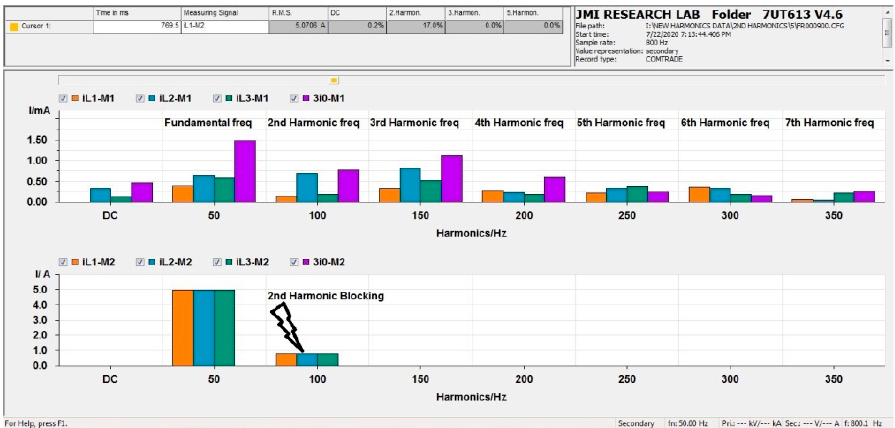
Figure 21. 2nd HB at 5000 mA Rated current & 18% of Inrush current condition.